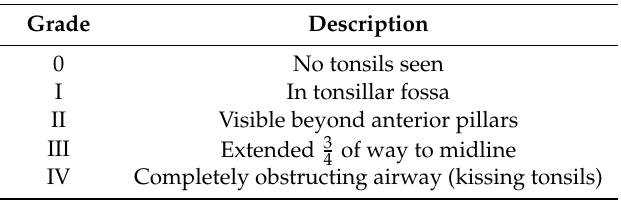
Table 2. Reproducibility of clinical grading of tonsillar